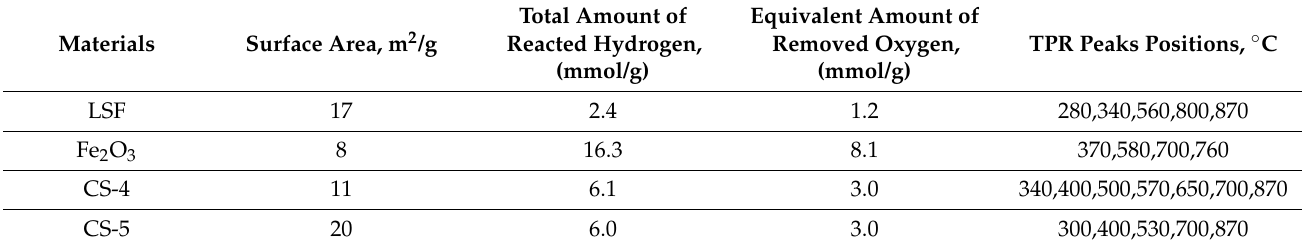
Table 4. H 2 -TPR peaks positions, total amount of hydrogen and oxygen reacted.